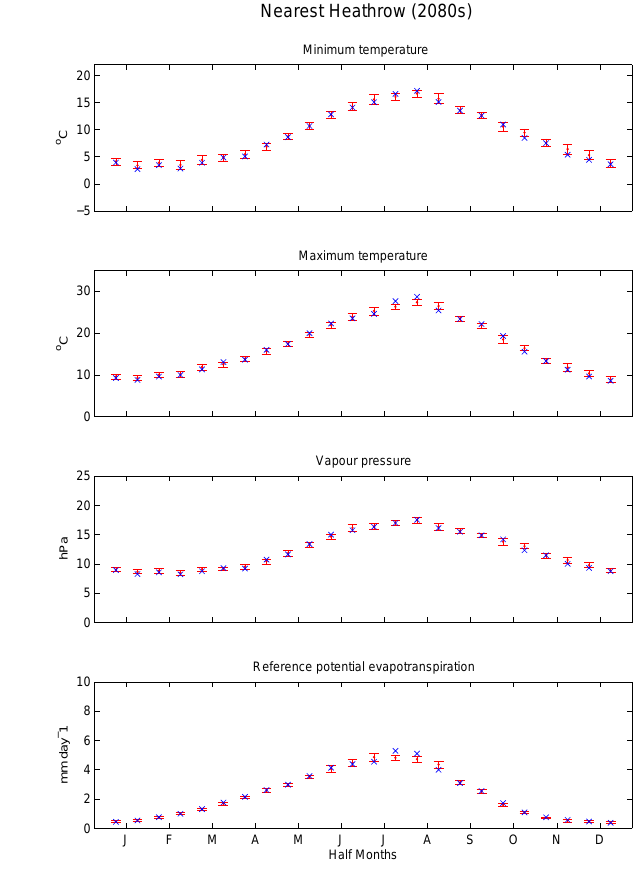
Fig. 3b. RCM 2080s scenario (HadRM3Q0 – blue, shown as crosses) and simulated (red dots and error bars) changes for each half month for the grid cell nearest Heathrow based on a 30yr pe- riod (1961–1990) showing the changes with respect to the RCM control period (Fig. 3a). The simulated values are the means of 100 weather generator runs. The lines and bars show the variability of the changes for the 100 runs (plotted as plus/minus two standard deviations around the mean).